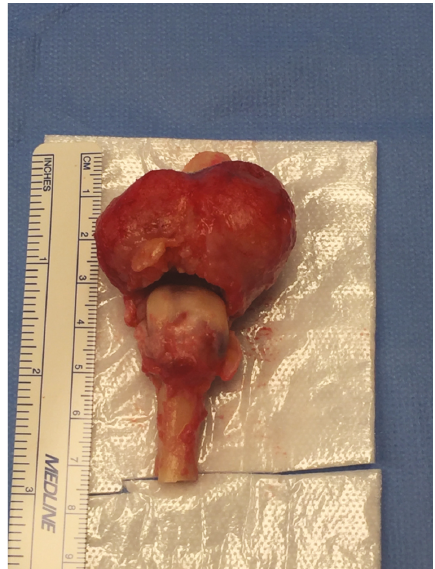
Figure 5: Gross surgical image of excised tumor specimen.